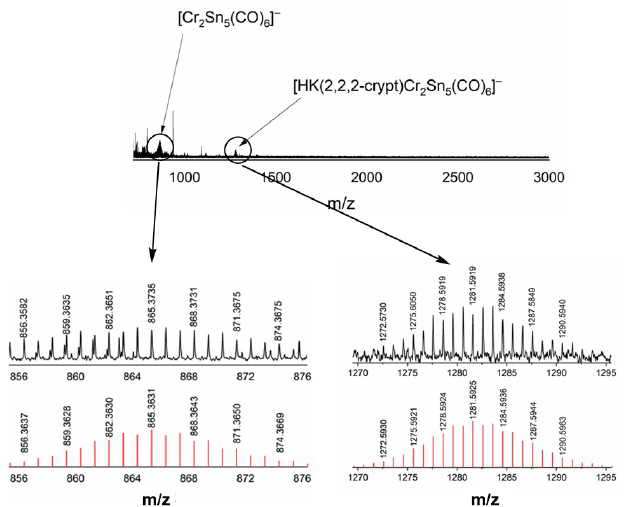
Figure 3. Negative-ion mode ESI-MS spectra of a freshly prepared solution of 1 in MeCN. The region of the spectrum corresponding to [Cr calculated